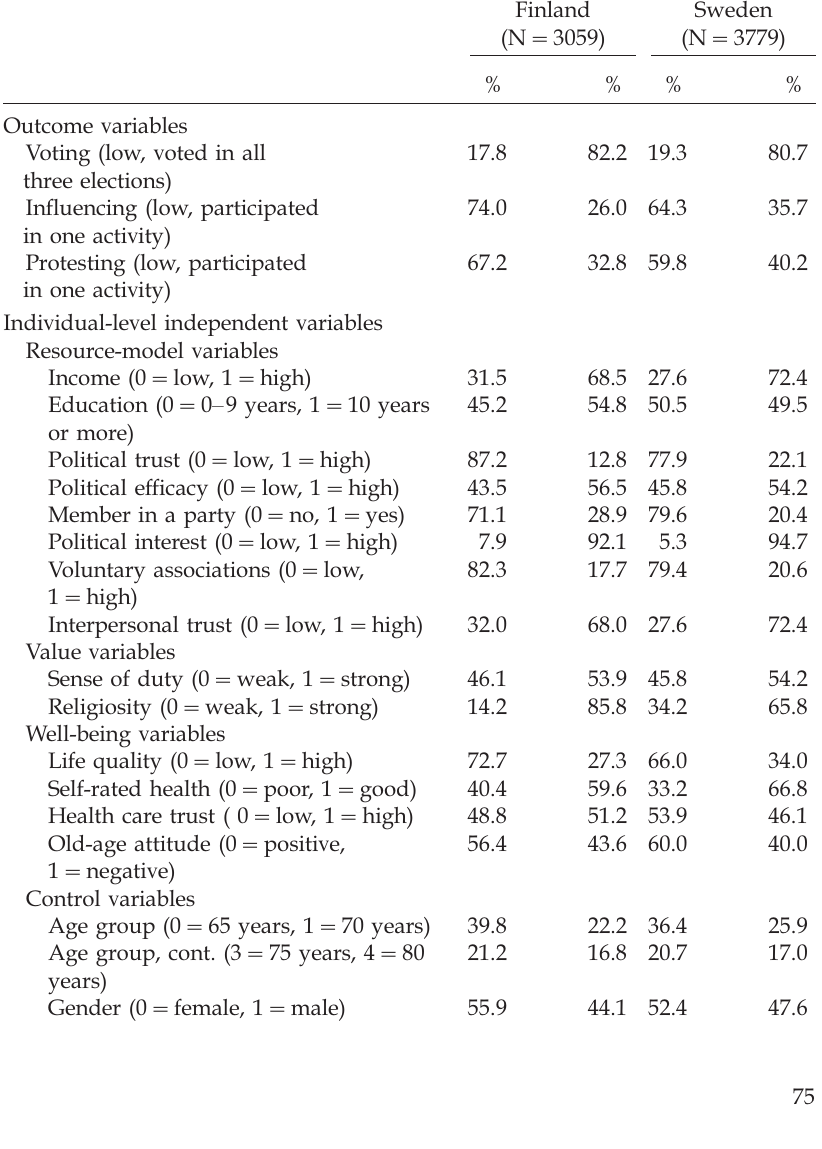
Table 1. The distribution of respondents (in%) by v ariable category and country (N (cid:3)